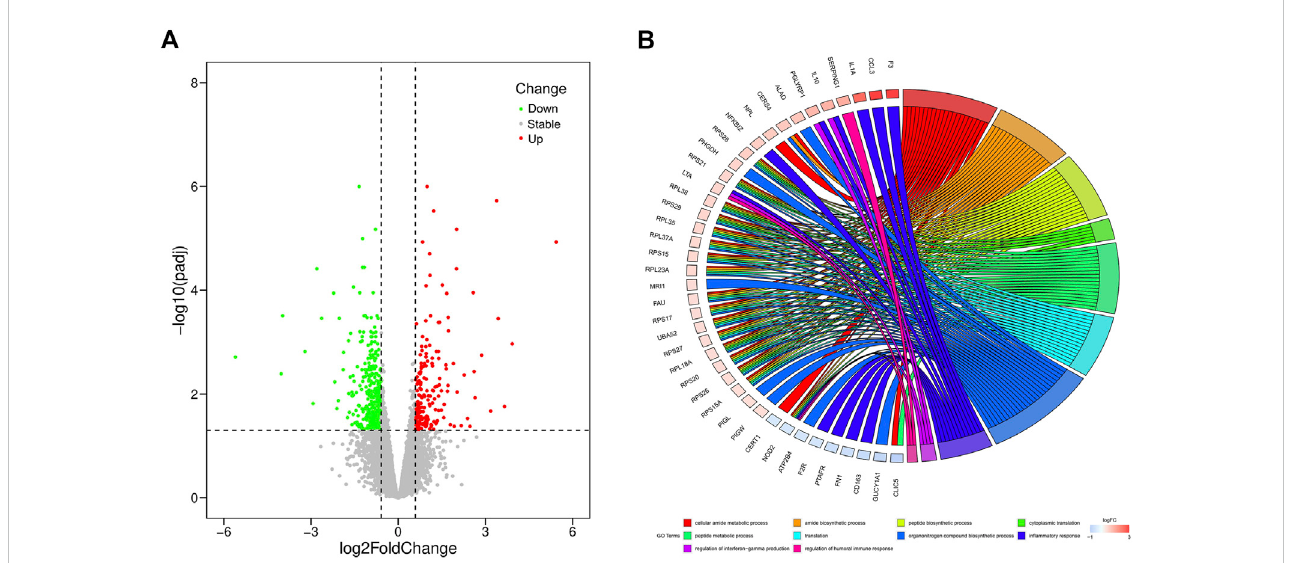
FIGURE 1 Volcano and circos plots of differentially expressed genes. (A) Volcano plot for expressed genes, it represents the -log10 ( p -value) ( y -axis) of genome- widegenesinrelationtotheirrespectivelog2(foldchange)( x -axis).Reddotsrepresentup-regulatedgenes,greendotsrepresentdown-regulatedgenes,and gray dots represent genes with no signi fi cant difference in expression (|log2FC| ≥ 0.585 and FDR < 0.05). (B) Circos plot for functional enrichment of DEGs. The colorgradientfrombluetoredontheleftsideofthegraphrepresentsthechangeofgenesfromdown-regulationtoup-regulation,andthetermsonthe right side are represented by different